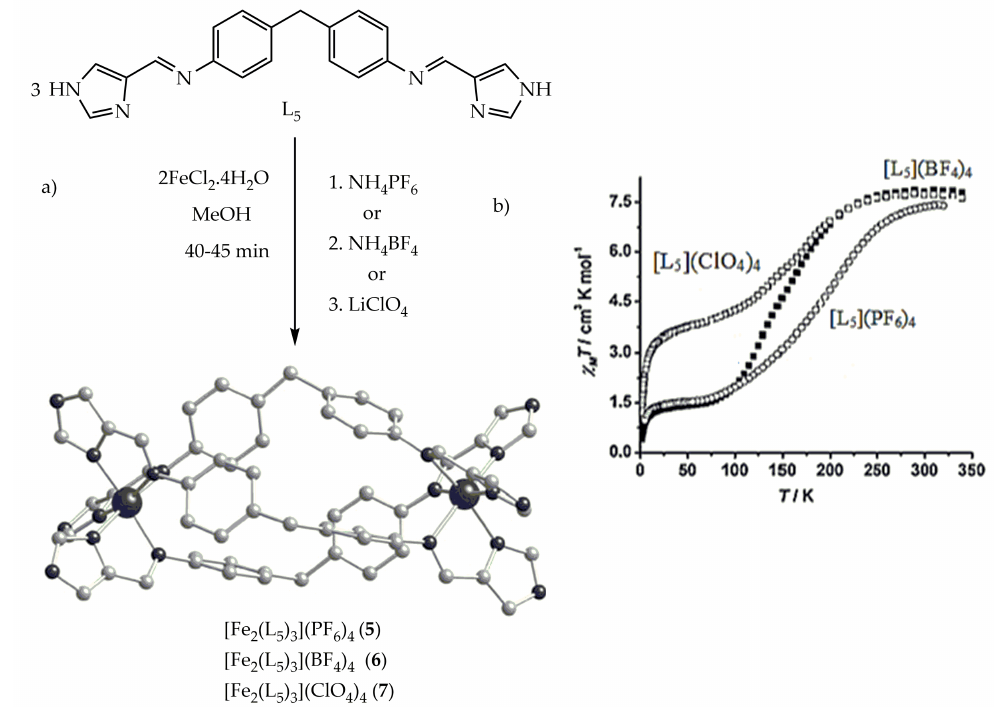
Figure 6. ( a ) The crystal structure of [Fe 2 (L 5 ) 3 ]X 4 complexes (X= PF 6 (5) or BF 4 ( 6 ) and ClO 4 ( 7 ) ( b ). Magnetic susceptibility χ M T vs. T plot for spiral complexes of 5 , 6 and 7 with different counter anions. Reproduced with permission from [70]; Published by Wiley,